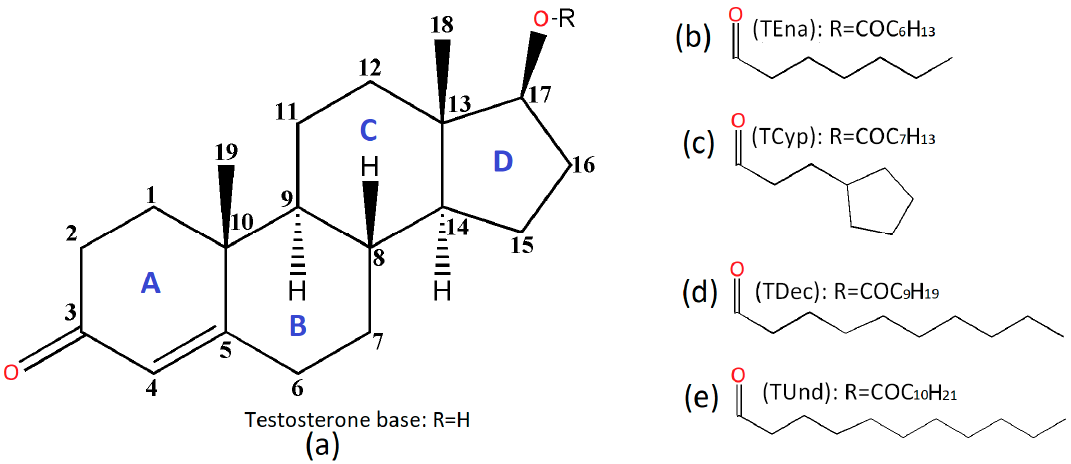
Figure 1. Chemical perspective of testosterone (17 β -Hydroxyandrost-4-en-3-one), showing the backbone labeling system ( a ) and the studied testosterone-based prodrugs: enanthate ( b ), cypionate ( c ), decanoate ( d ), undecanoate ( e ).